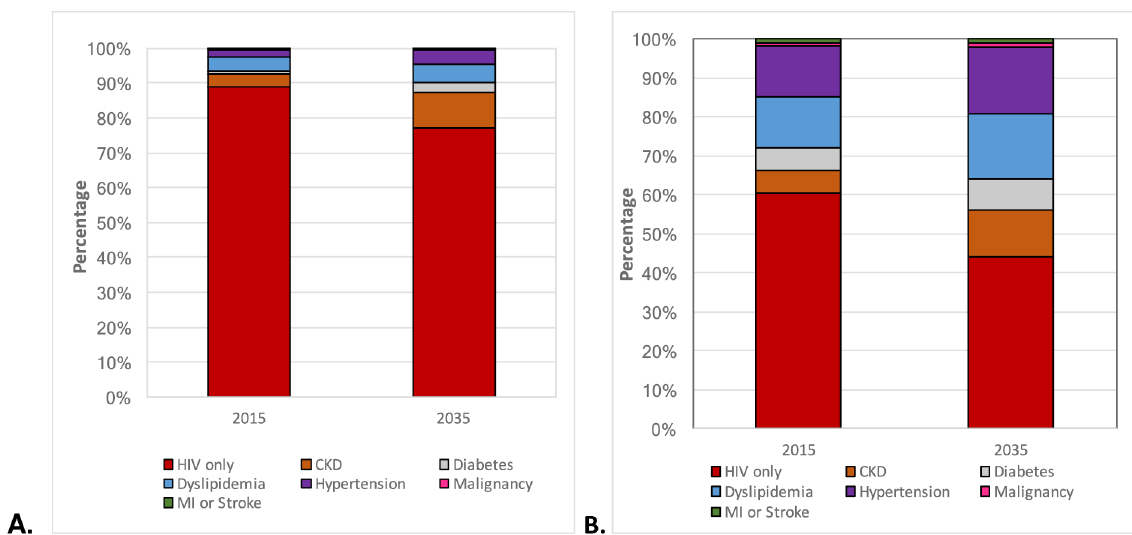
Fig 4. Percentage contribution of HIV and NCD treatment costs to overall costs of care of HIV-positive patients on antiretroviral therapy in 2015 and 2035 in A. Italy and B. the USA. Abbreviations : Chronickidney disease(CKD) , Myocardial infraction (MI)